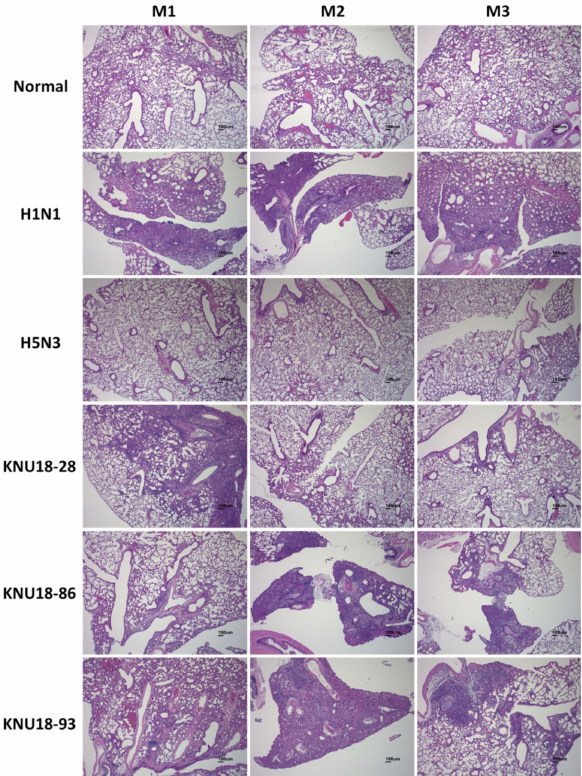
Figure 6. Histology of lung inflammation examined by hematoxylin and eosin (H&E) staining. BALB/c mice were intranasally challenged with 10 5 EID 50 /mouse ( n = 3) of three novel H5N2 isolates (KNU18-28, KNU18-86, and KNU18-93) and two control virus strains (H1N1 and H5N3). The infected mouse lungs were collected for H&E staining at 6 dpi (scale bar, 100 µ m; original magnification, 40 ×